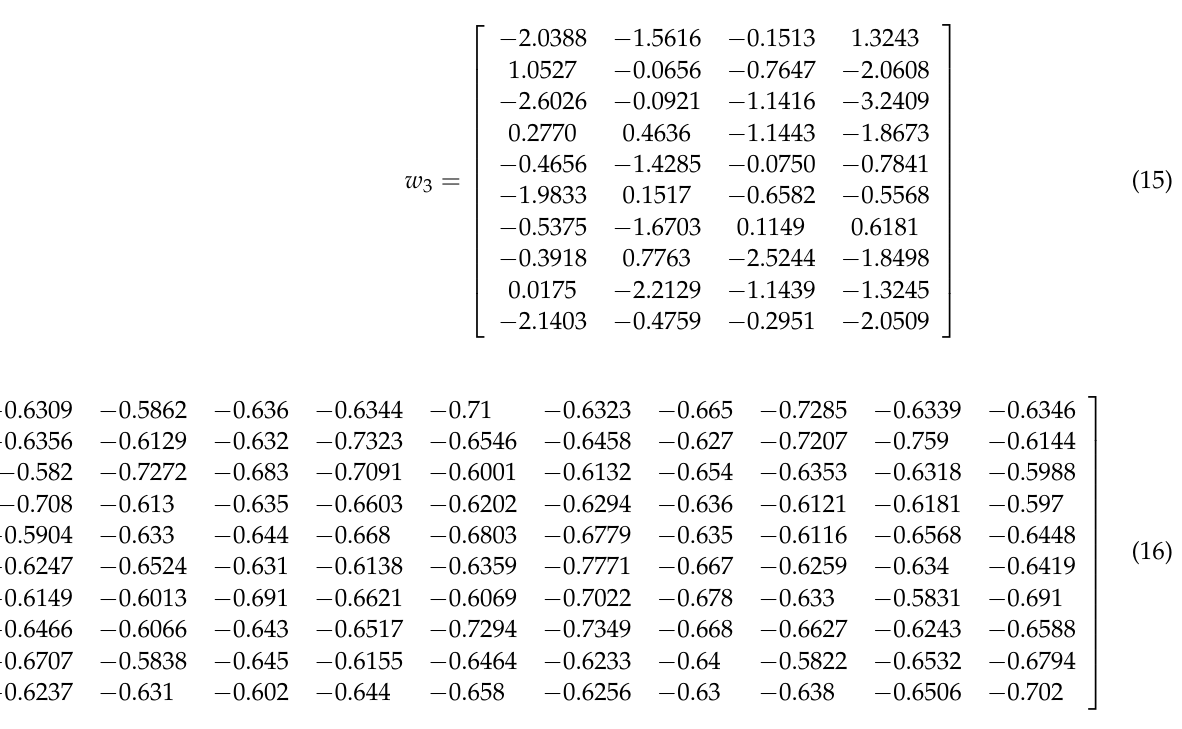
Figure 11. Grid structure of SSA-ENN model. For training the model, other grid parameters, such as the learning rate, minimum error of training target, and initial population size of SSA, were optimized by trial and error and set to 0.01, 0.0001, and 30, respectively. Then, the weights and thresholds of the ENN were optimized by the SSA based on the training set, and the optimized weight matrices w 3 , w 4 , and w 5 were obtained as